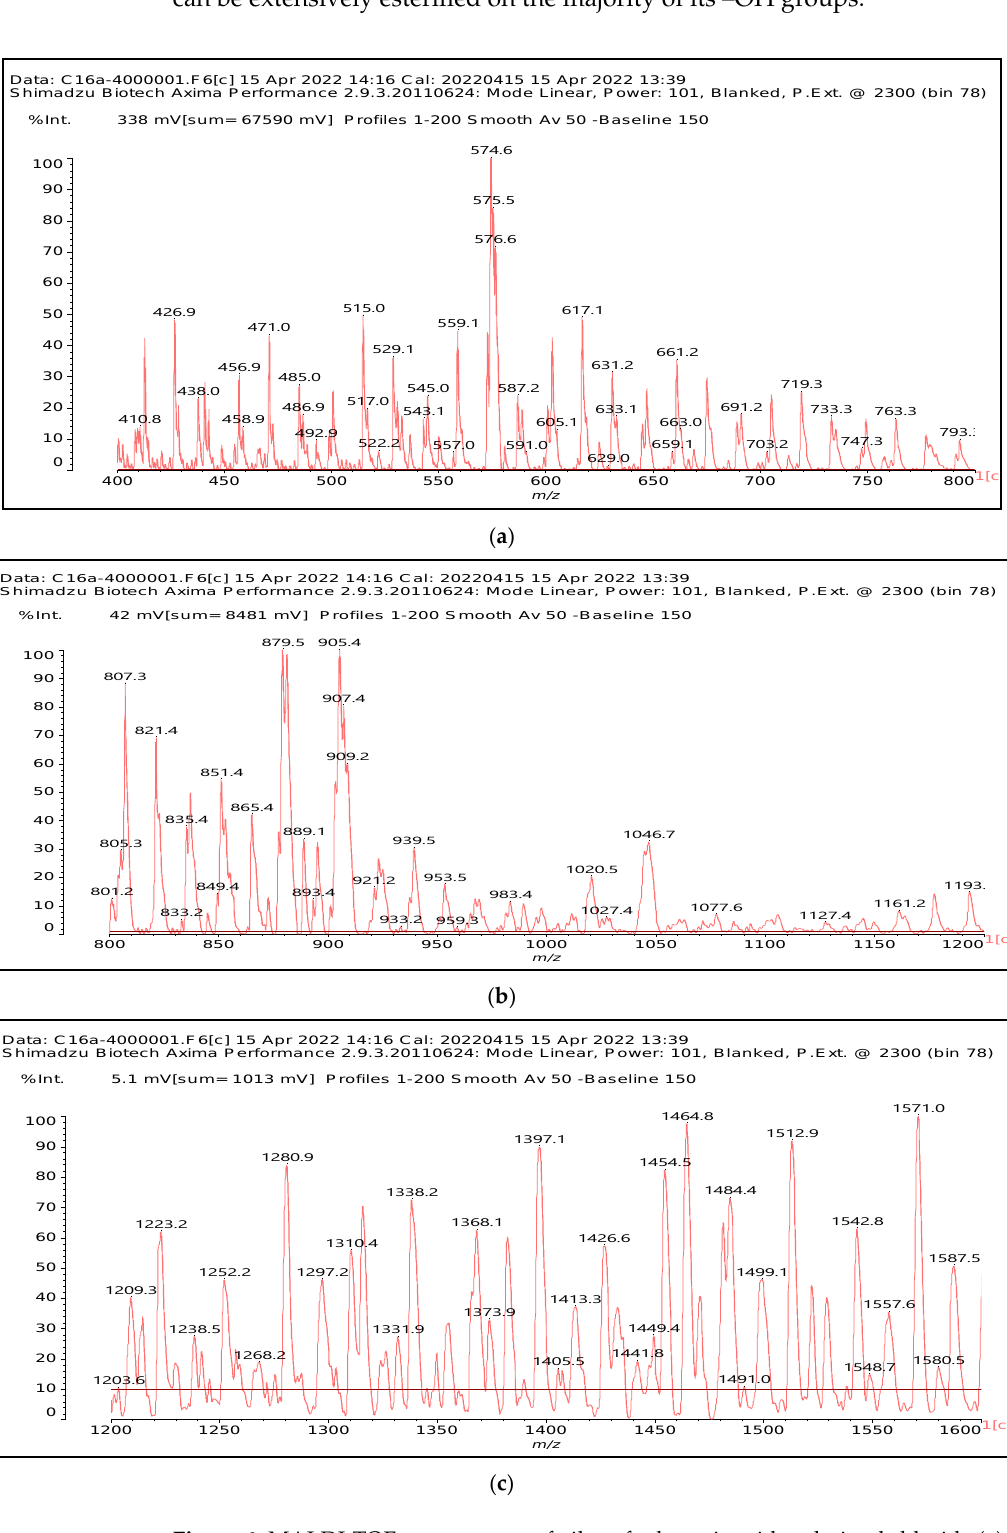
Figure 6. MALDI-TOF mass spectra of oil-grafted tannin with palmitoyl chloride ( a ) from 400 Da to 800 Da, ( b ) from 800 Da to 1200 Da, ( c ) from 1200 Da to 1600 Da.